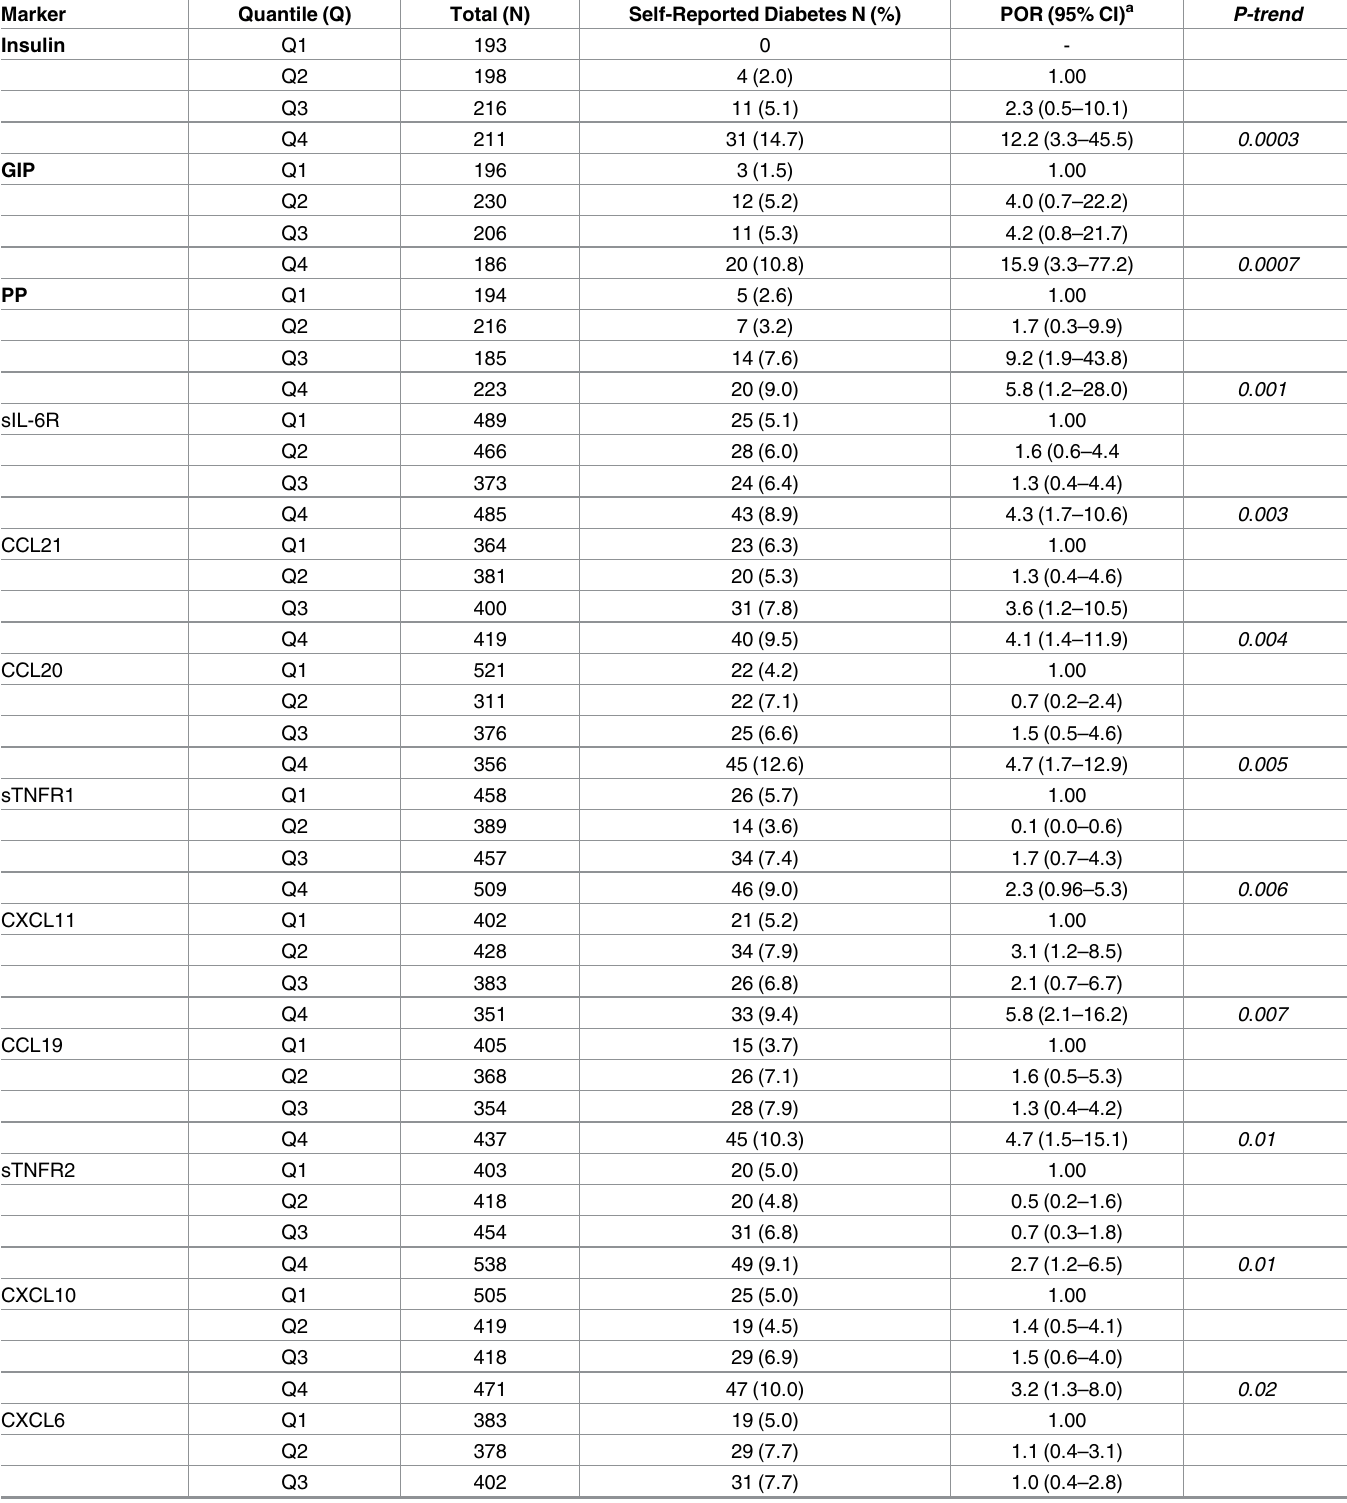
Table 2. Associations between inflammation-, immune-, and metabolic-related markersand self-reported